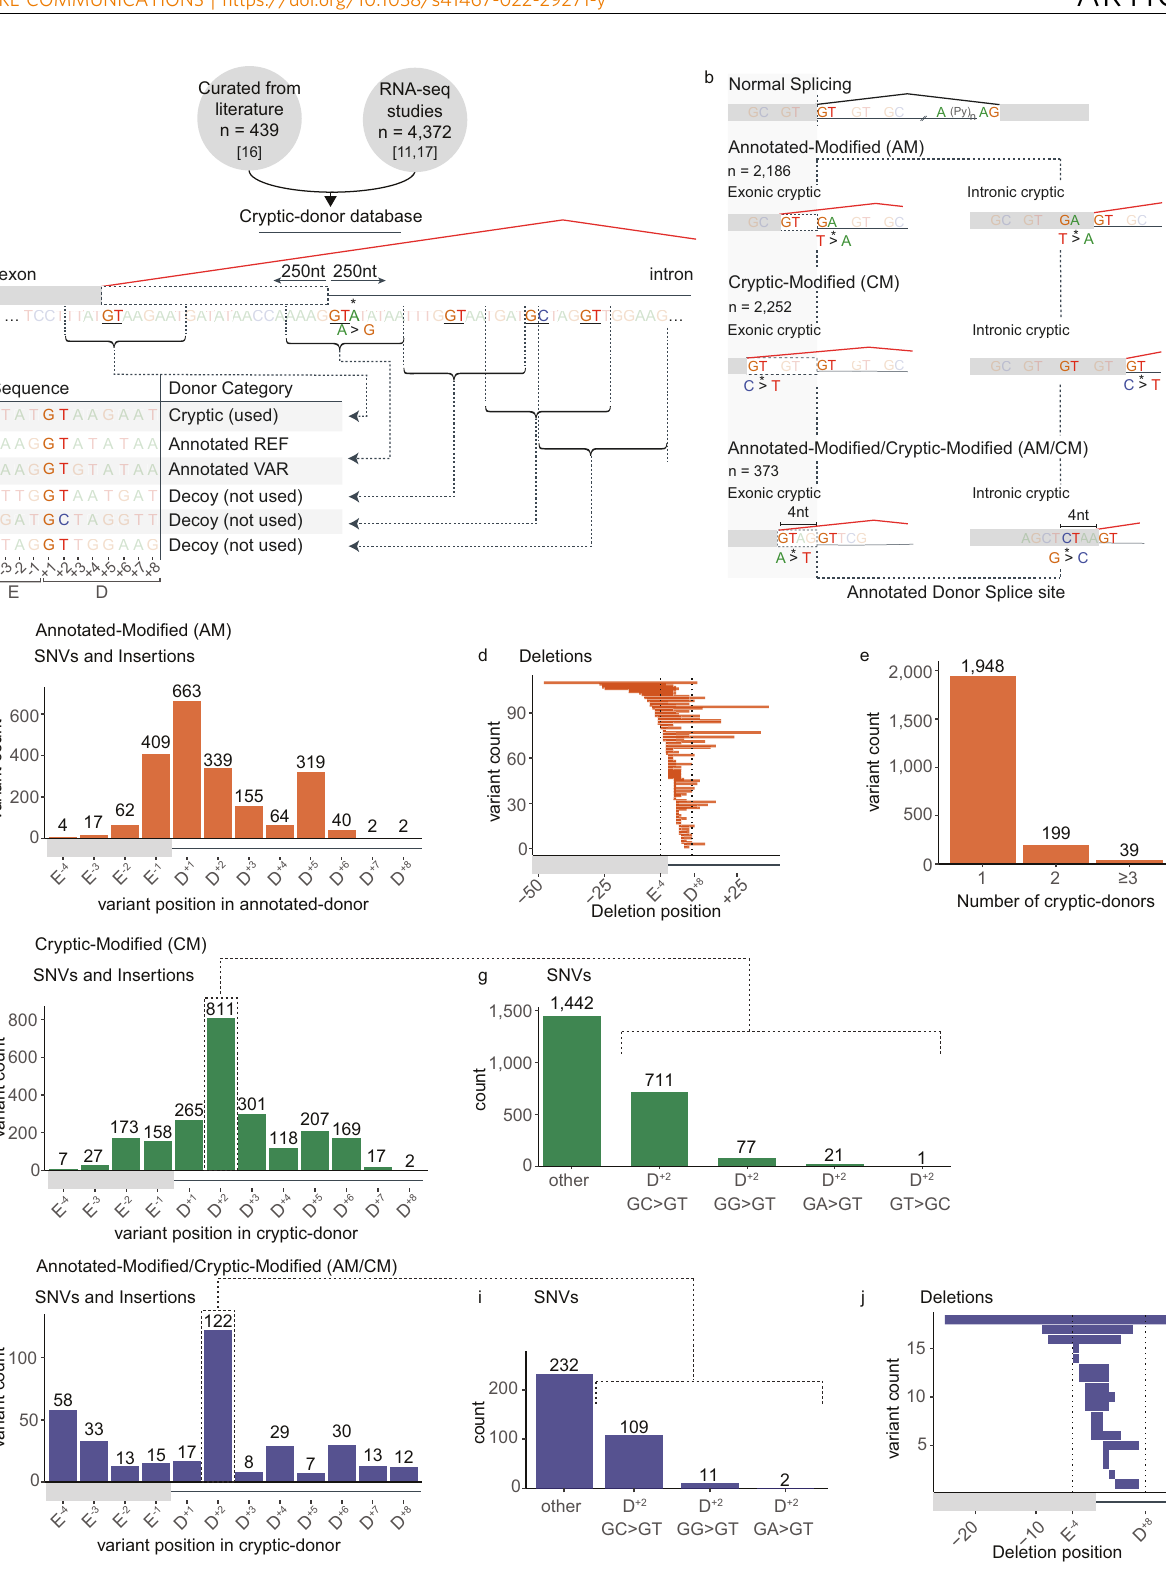
NATURE COMMUNICATIONS| (2022) 13:1655